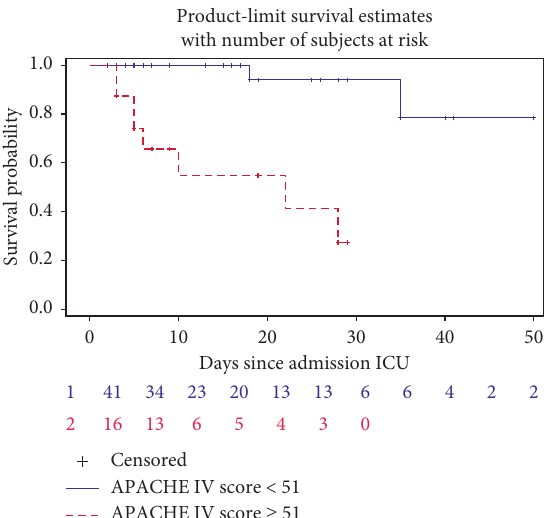
Figure 3: Kaplan–Meier survival curve of critically ill COVID-19 patients stratified by the APACHE IV score. The number of patients at risk is shown in the